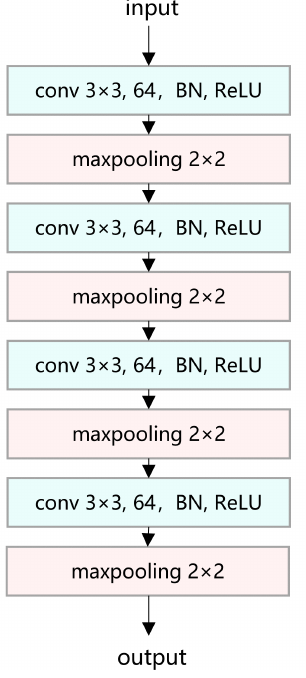
Figure 4. The architecture of CNN as the